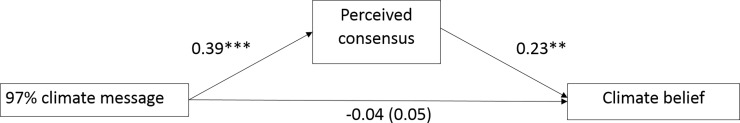
The effect of a 97% climate message on belief in human-caused climate change, mediated via perceptions of consensus among climate scientists, controlling for pre-treatment estimates.Standardized regression coefficients. **p < .01,***p < .001. N = 264.